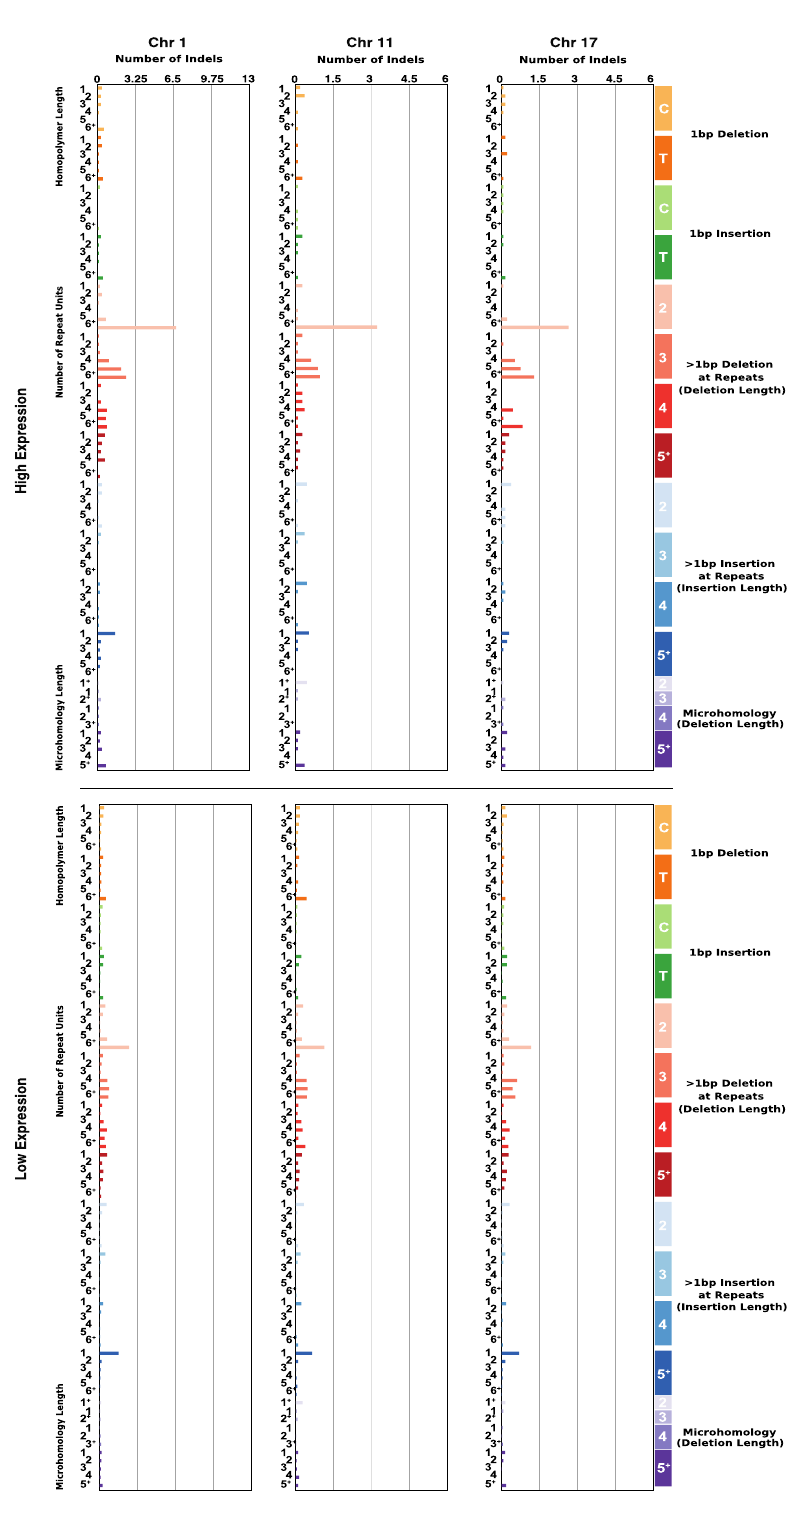
Figure 3. Indel distribution of chromosomes 1, 11, and 17. Bar plots of the average number of point insertions and deletions across samples by E6/E7 high expression and low expression. Patients were categorized by E6/E7 joint- TPM, with TPM ≥ 20 considered high expression, and TPM < 20 low expression.